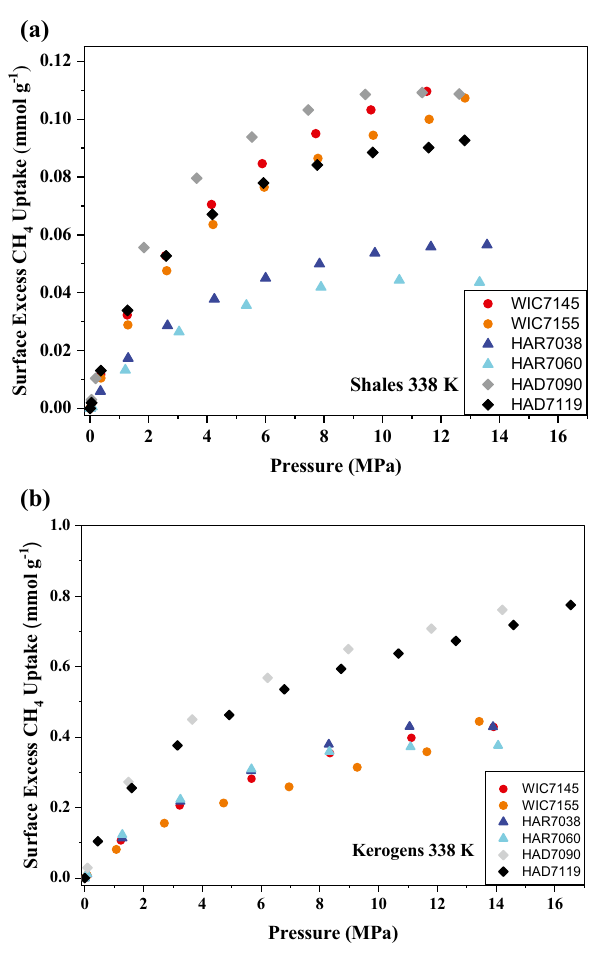
Fig. 8 Supercritical CH adsorption isotherms at 338 K for a shales 4 and b isolated kerogens (data from [34])